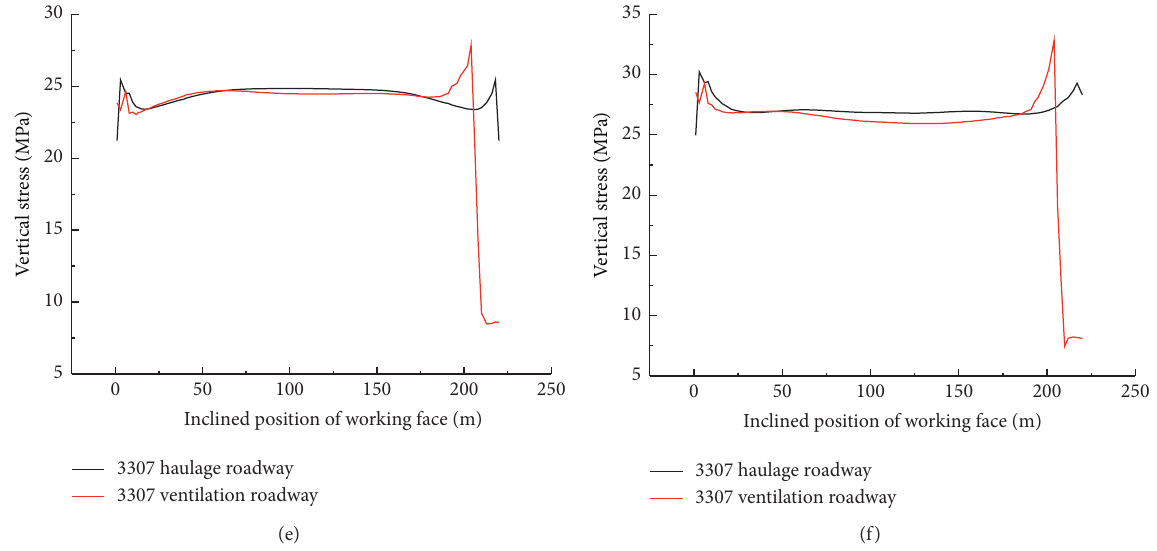
Figure 7: Vertical stress curves of two working conditions. (a) Stress monitoring value of #1 survey line. (b) Stress monitoring value of #2 survey line. (c) Stress monitoring value of #3 survey line. (d) Stress monitoring value of #4 survey line. (e) Stress monitoring value of #5 survey line. (f) Stress monitoring value of #6 survey